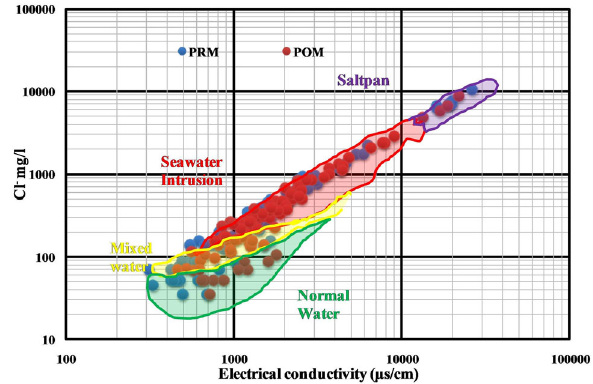
Fig. 9 Cl - versus electrical conductivity showing normal ground- 2005)